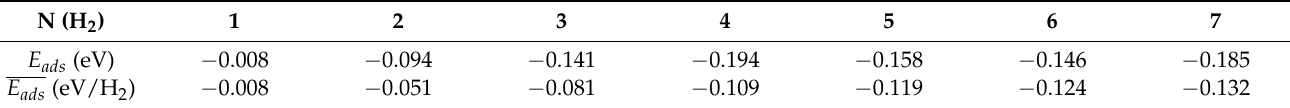
Table 5. Hydrogen adsorption energy and average adsorption energy of